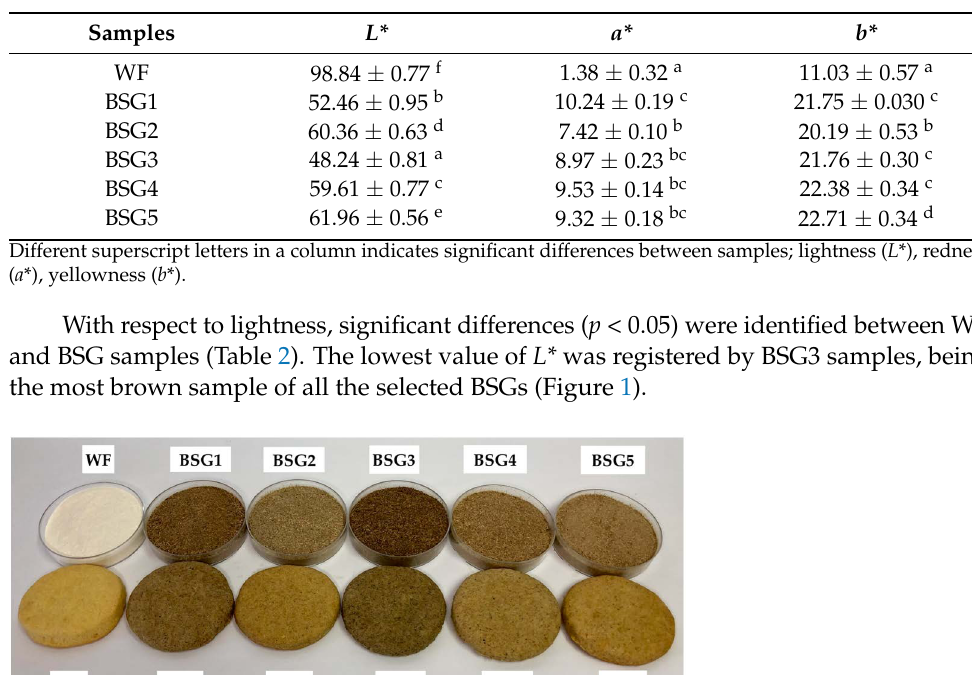
Table 2. Color characteristics (CIE L* , a* , b* values) of BSG (brewers spent grains) types and WF (wheat flour).